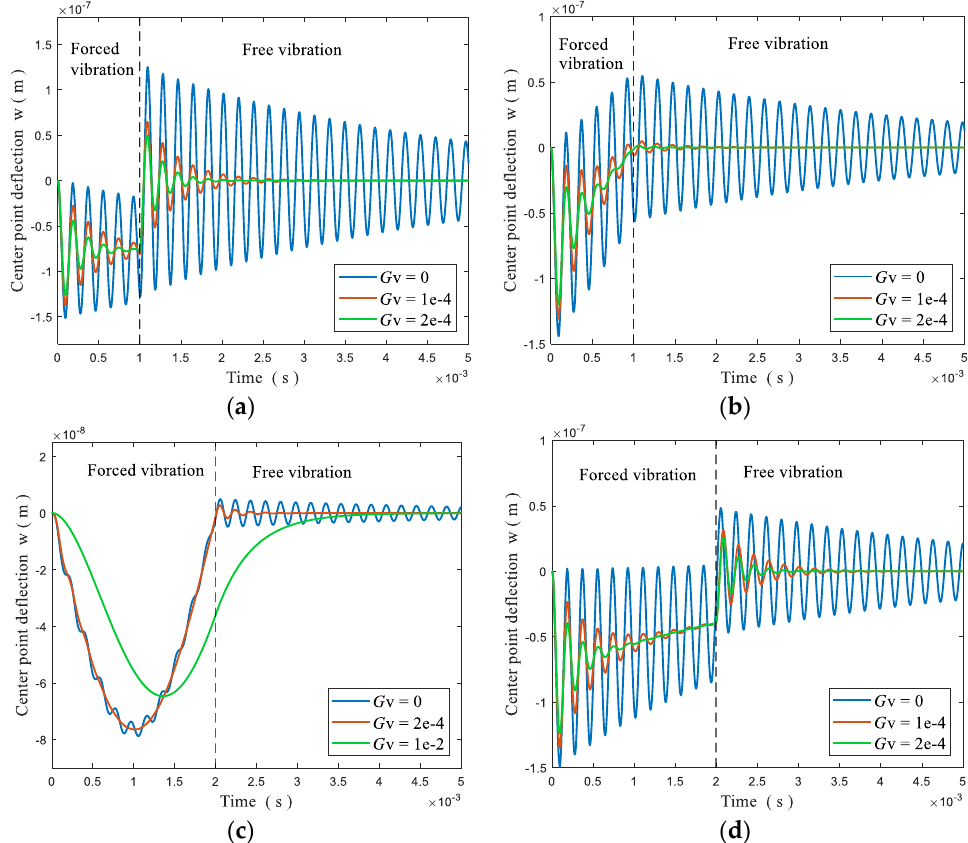
Figure 18. Transient deflection responses of a CCCC PFGP under four different time-varying loads: ( a ) Step load; ( b ) triangular load; ( c ) sinusoidal load; ( d ) explosive load.